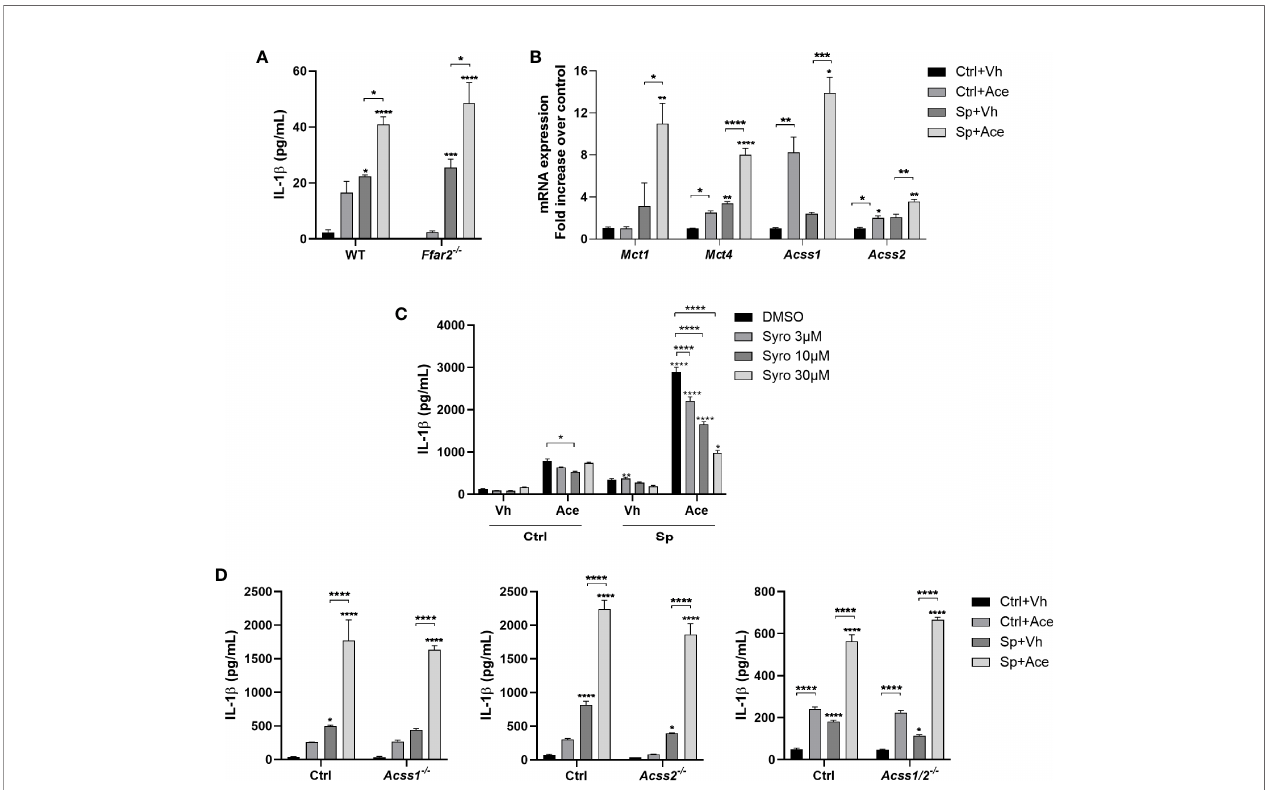
FIGURE 3 | IL-1 b production driven by acetate is independent of FFAR2, ACSS1 and ACSS2. (A) ELISA for IL-1 b from supernatant of alveolar macrophages obtained from WT and Ffar2 -/- mice pre-treated or not with acetate, stimulated or not with S. pneumoniae for 24 h. (B) Fold increase of mRNA from monocarboxylate transporters ( Mct ) and acetyl-CoA synthetase ( Acss ) assessed by RT-PCR from MPI cells pre-treated or not with acetate and stimulated or not with S. pneumoniae for 18 h. Fold increase was calculated over control (Ctrl+Vh). (C, D) ELISA for IL-1 b from supernatant of MPI cells (C) or MPI control, Acss1 -/- , Acss2 -/- and Acss1/2 -/- cells (D) pre-treated or not with acetate and Syrosingopine (C) and stimulated or not with S. pneumoniae for 24 h. Bars showing the mean and error showing the SEM of triplicates. Results are representative of three independent experiments. Statistical analysis was done using Two-way ANOVA corrected with Tukey ’ s (A, D) or Sidak ’ s multiple comparisons test (B, C) (*p < 0.05, **p < 0.01, ***p < 0.001, ****p <